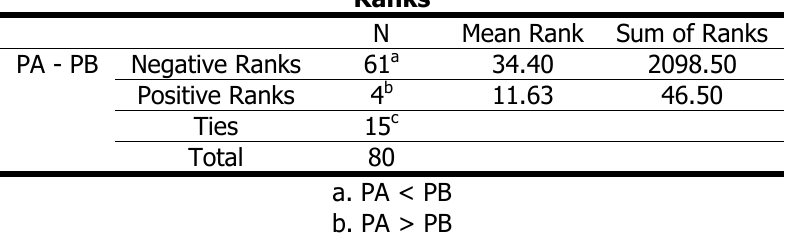
Table 2. Wilcoxon Signed Ranks Physical Motivation Test